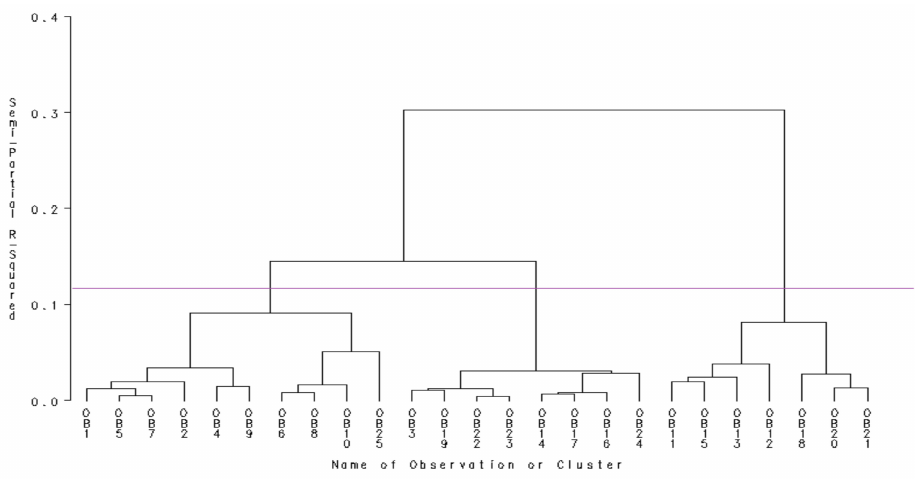
Figure 5. Cluster generation dendogram provided by the SAS Enterprise Guide